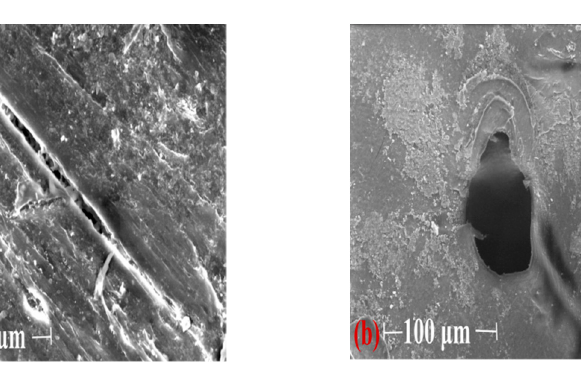
Figure 2. The morphology of the microplastics under a stereomicroscope (magnification: 20 × ~40 × ). ( a , b ) were from water samples in the study area.